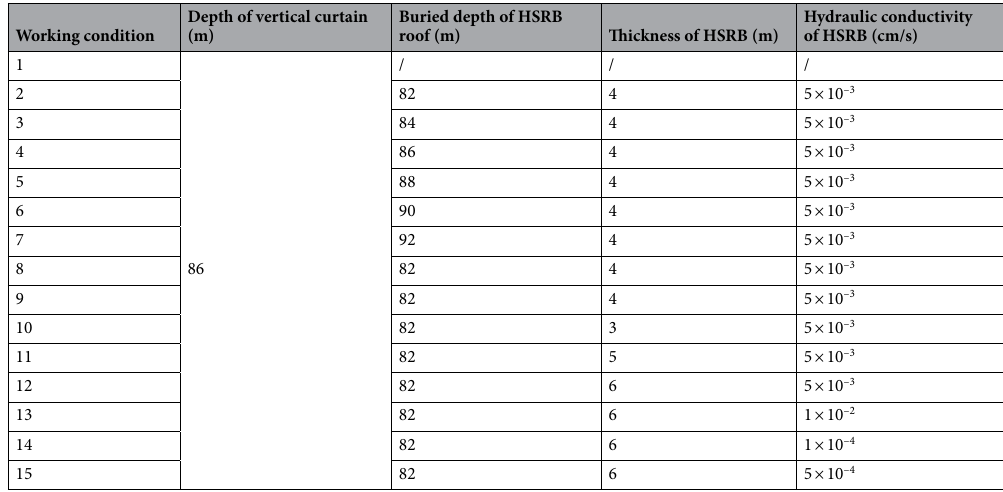
Buried depth of HSRB roof